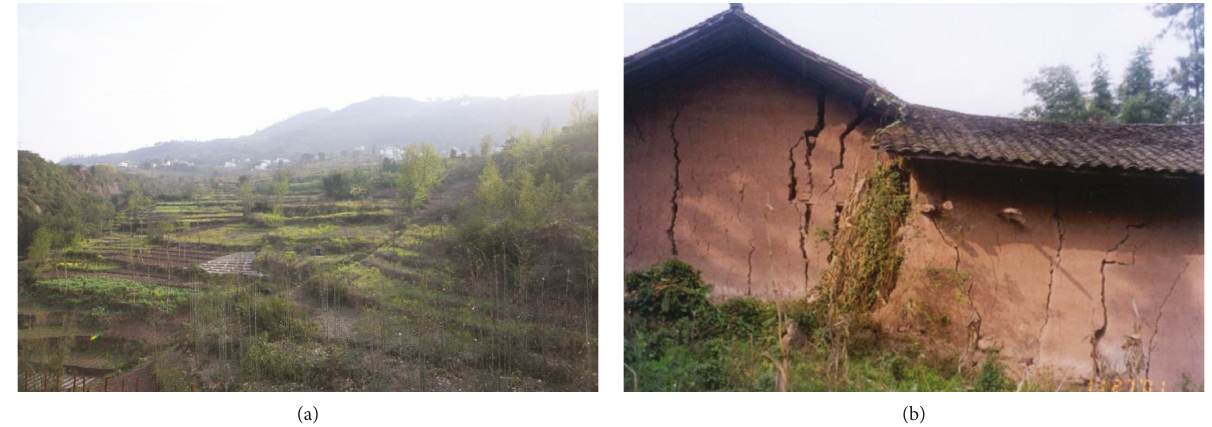
Figure 7: (a) A view of Dasha landslides; (b) tensional cracks in house